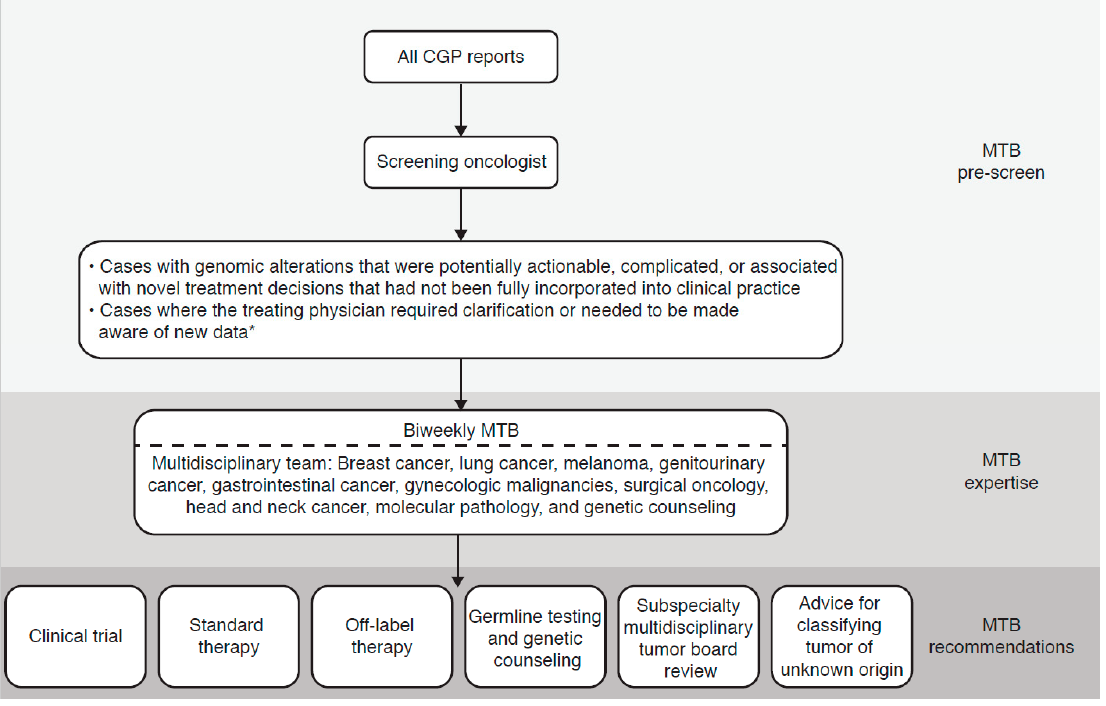
Figure 1. Molecular tumor boards (MTB) workflow and review process. * Data relevant to approvals and/or recommendations for the targeted therapy to be administered. CGP, comprehensive genomic profiling; MTB, molecular tumor